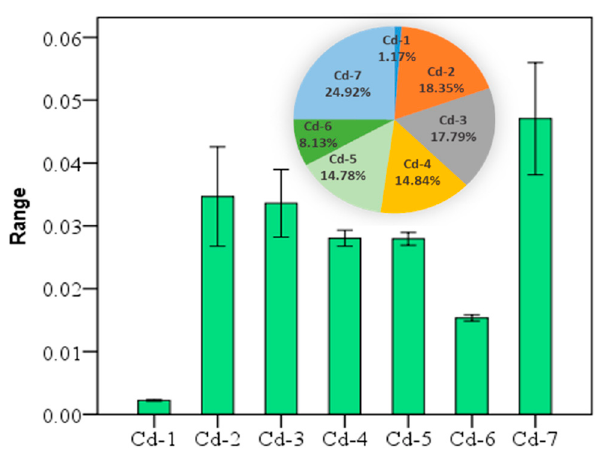
Figure 2. The mean ± standard error of seven fractions of cadmium (Cd) at the 95% confidence interval, and the percentage of each fraction of the total (unit: mg/kg).